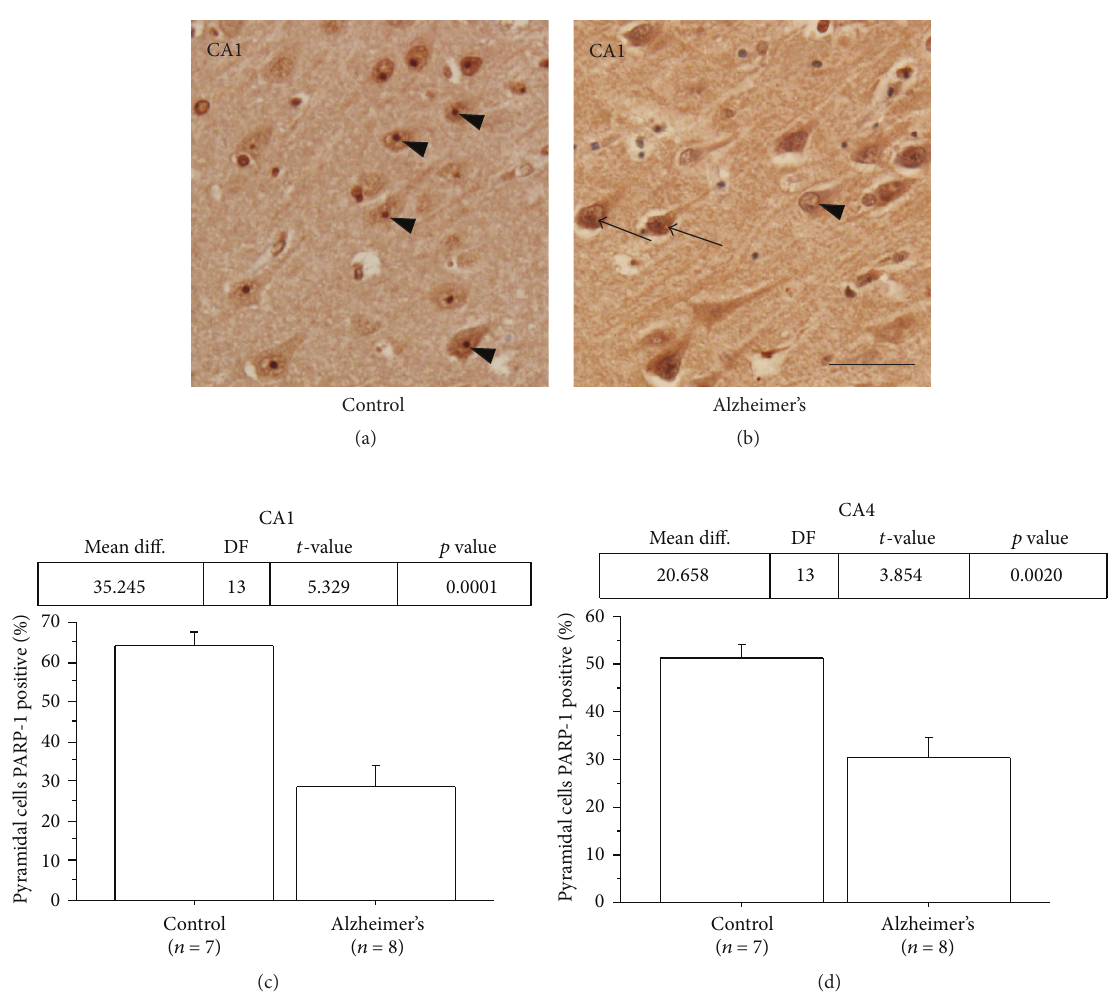
Figure 1: Nucleolar PARP-1 immunoreactivity in AD ranged from absent to dispersed and less intense compared to that of controls. ((a) and (b)) Representative immunostaining with diaminobenzidine (DAB) of human hippocampal pyramidal neurons in CA1 region. (a) Prominent nucleolar staining of PARP-1 (arrows) was seen in most of pyramidal neurons of a control case. (b) The nucleolar staining of PARP-1 ranged from absent (arrowheads) to a more dispersed pattern with less intensity of label (arrows) in pyramidal neurons of an AD case. ((c) and (d)) Percentages of CA1 and CA4 hippocampal pyramidal neurons with PARP-1 positive nucleoli were significantly lower in AD cases compared to controls. (Control, 𝑛 = 8 ; AD, 𝑛 = 8 ; ∗ 𝑝 < 0.05 .) Scale bar = 50 𝜇